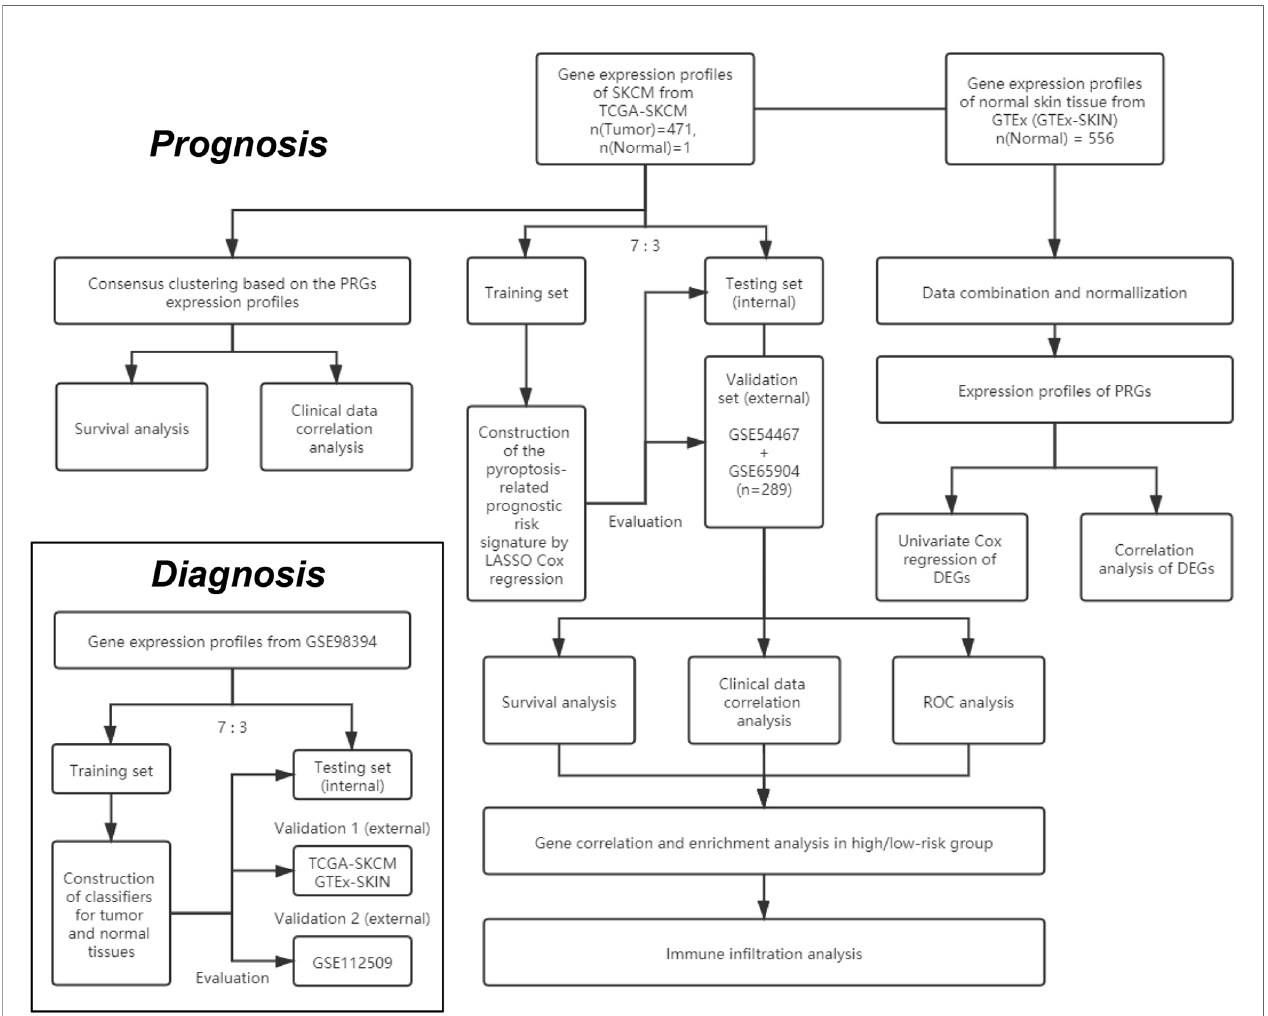
FIGURE 1 | The fl owchart of the overall procedures. This fl owchart illustrates the process of data collection and analyses for diagnostic and prognostic